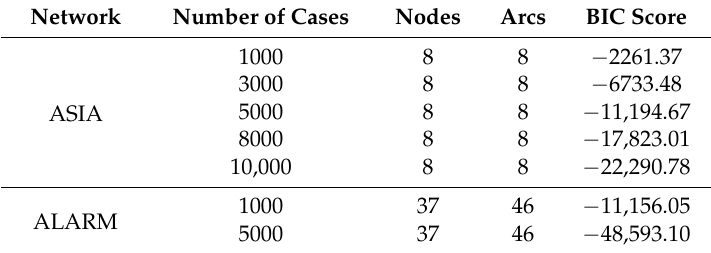
Table 1. A summary of the datasets used in the experiments.